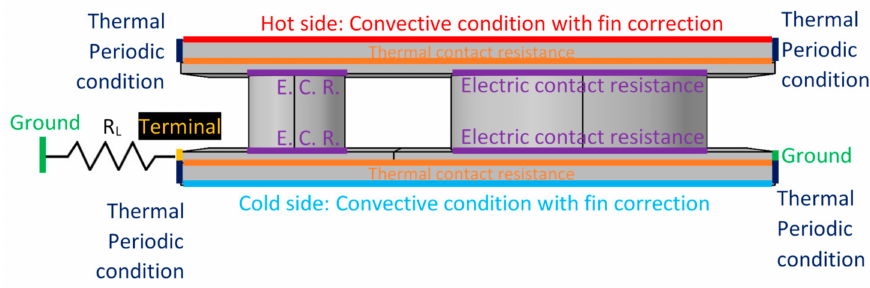
Figure 7. Outline of electrical and thermal boundary conditions used in the